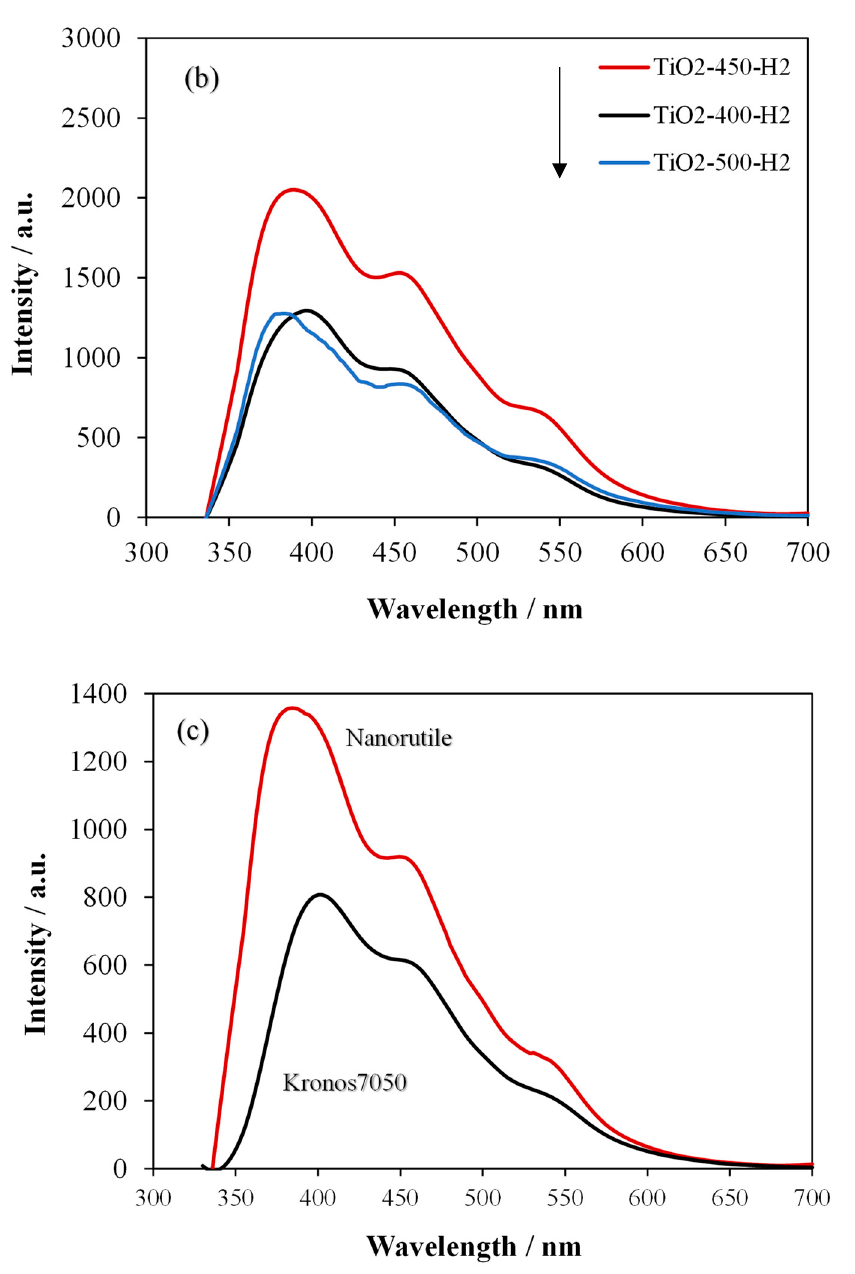
Figure 4. Photoluminescence spectra of titania samples ( a ) heat-treated in argon, ( b ) heat-treated under hydrogen, and ( c ) commercial.